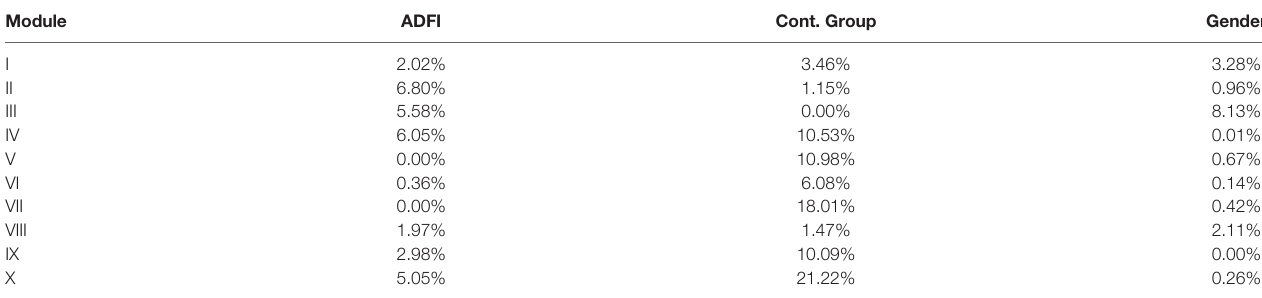
TABLE 4 | Proportional variance in individual loading values explained by average daily feed intake (ADFI), contemporary group, and gender in each of the modules obtained from the tensor decomposition. Module